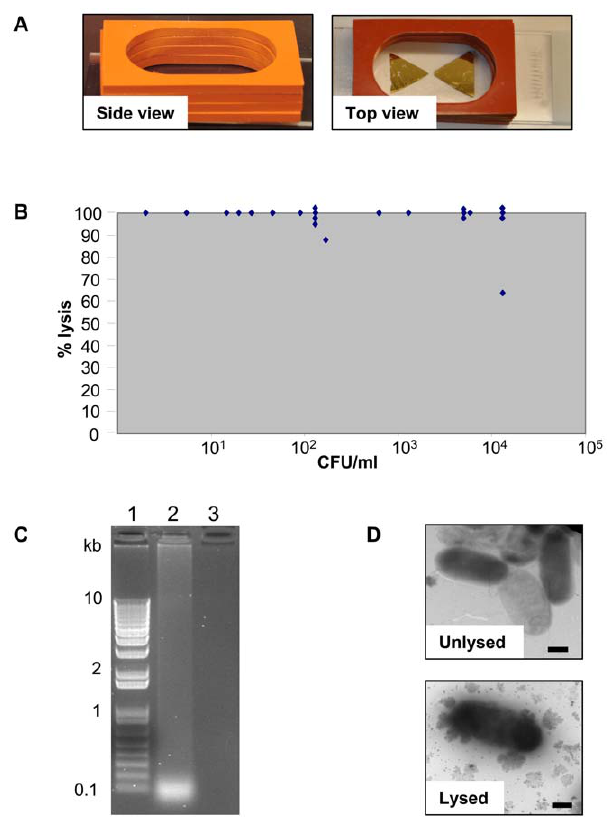
Figure 1. Lysis of S . Enteritidis. (A) Gold lysing triangles with bowtie configuration. (B) Lysis of biologically relevant concentrations of CVD 1920 (pGEN206). 2 CFU/ml to 1.3 6 10 4 CFU/ml were lysed using gold lysing triangles and heated for 13 s on high power in a GE microwave Model No. JE2160BF01. (C) Agarose gel of DNA released from lysed CVD 1920 (pGEN206). An overnight culture of bacteria (1.9 6 10 10 CFU/ml) was lysed using gold lysing triangles and microwave radiation. Lane 1, 1 kb Plus DNA ladder (Invitrogen); 2, lysed bacteria; 3, unlysed bacteria. (D) Transmission electron micrographs of lysed and unlysed CVD 1920 (pGEN206). Bar=500 nm.